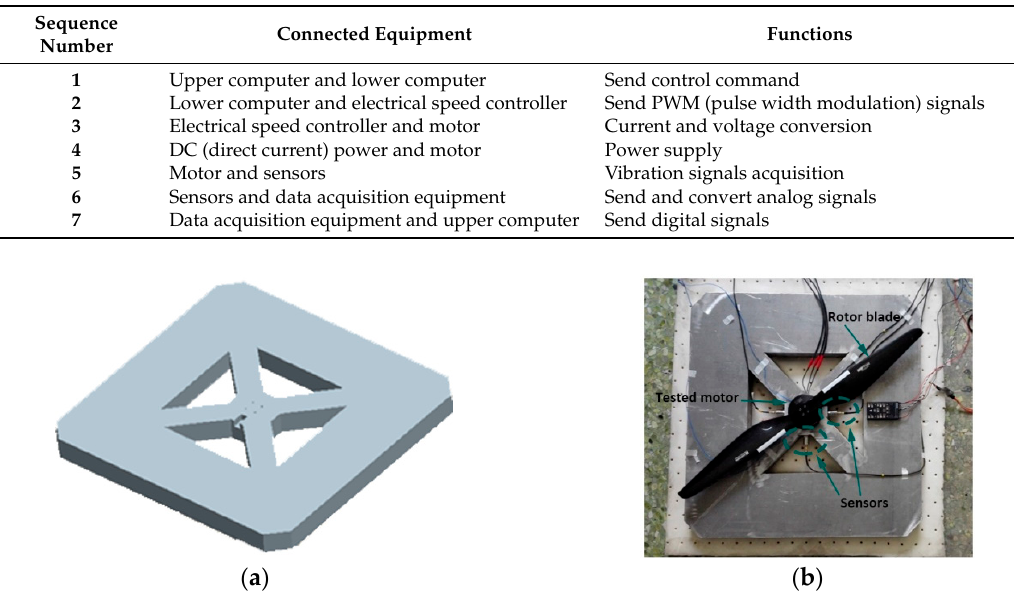
Figure 8. Fixture and devices used in the experiment: ( a ) fixture; ( b ) experiment devices. Table 3. Working parameters of the tested